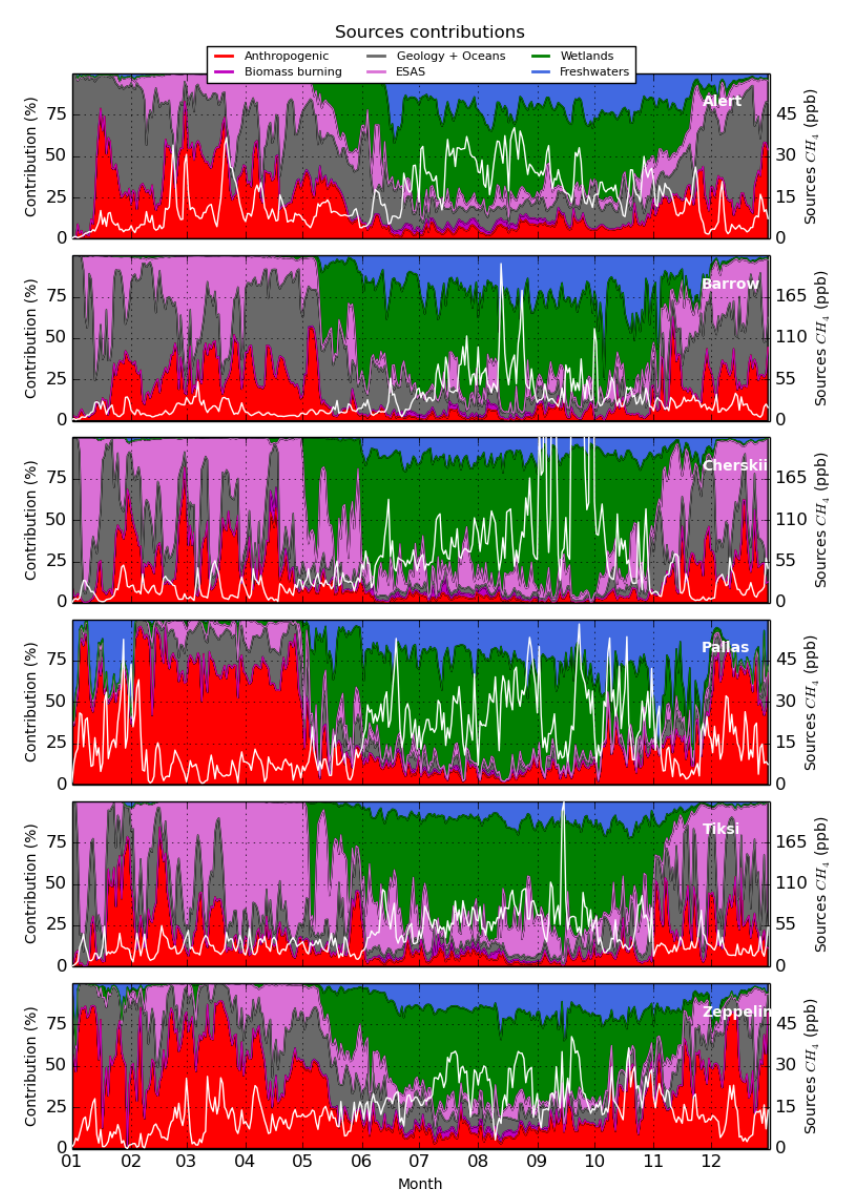
Figure 5. Sources contributions (in %, left axis) to the CH 4 abundance (excluding CH 4 resulting from the boundary conditions) simulated by CHIMERE at six measurement sites in 2012. Red: anthropogenic emissions. Magenta: biomass burning. Grey: geology and oceans. Pink: ESAS. Green: wetlands. Blue: freshwater systems. The white line represents the CH 4 mixing ratio resulting from all the sources emitted in the domain (in ppb, right axis). Maximum contribution for Cherskii CH 4 exceeds the chosen scale and reaches